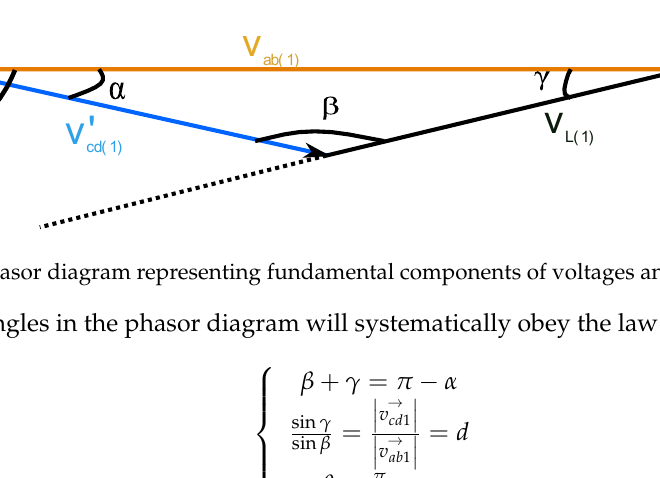
Figure 2. Simplified equivalent circuit of DAB DC-DC converter.